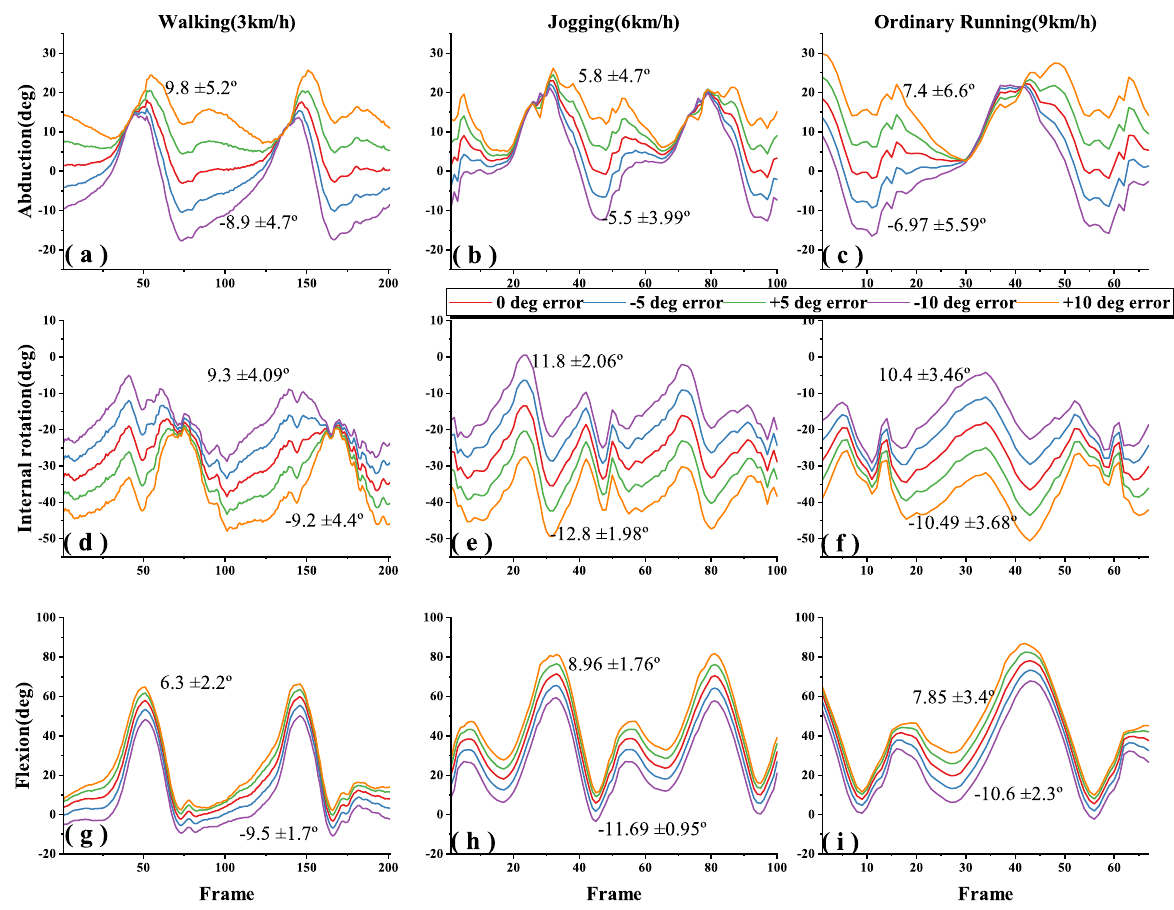
Figure 5. Effects of IMU to thigh misalignment error on 3-DOF knee angle estimation during different motions. The blue, green, purple and orange lines indicate the knee angle estimates after adding errors of − 5 ◦ , +5 ◦ , − 10 ◦ and +10 ◦ to the I2S alignment parameters, and the red line indicates the knee angle estimates without artificially added errors. ( a – c ), ( d – f ), ( g – i ) are the abduction, internal rotation and flexion angles of the knee during walking (3 km/h), jogging (6 km/h) and ordinary running (9 km/h) on treadmill. For example, in ( a ), 9.8 ± 5.2 ◦ denote that the abduction mean error is 9.8 ◦ and the SD is 5.2 ◦ when the introduced IMU to thigh misalignment error is +10 ◦ during the walking